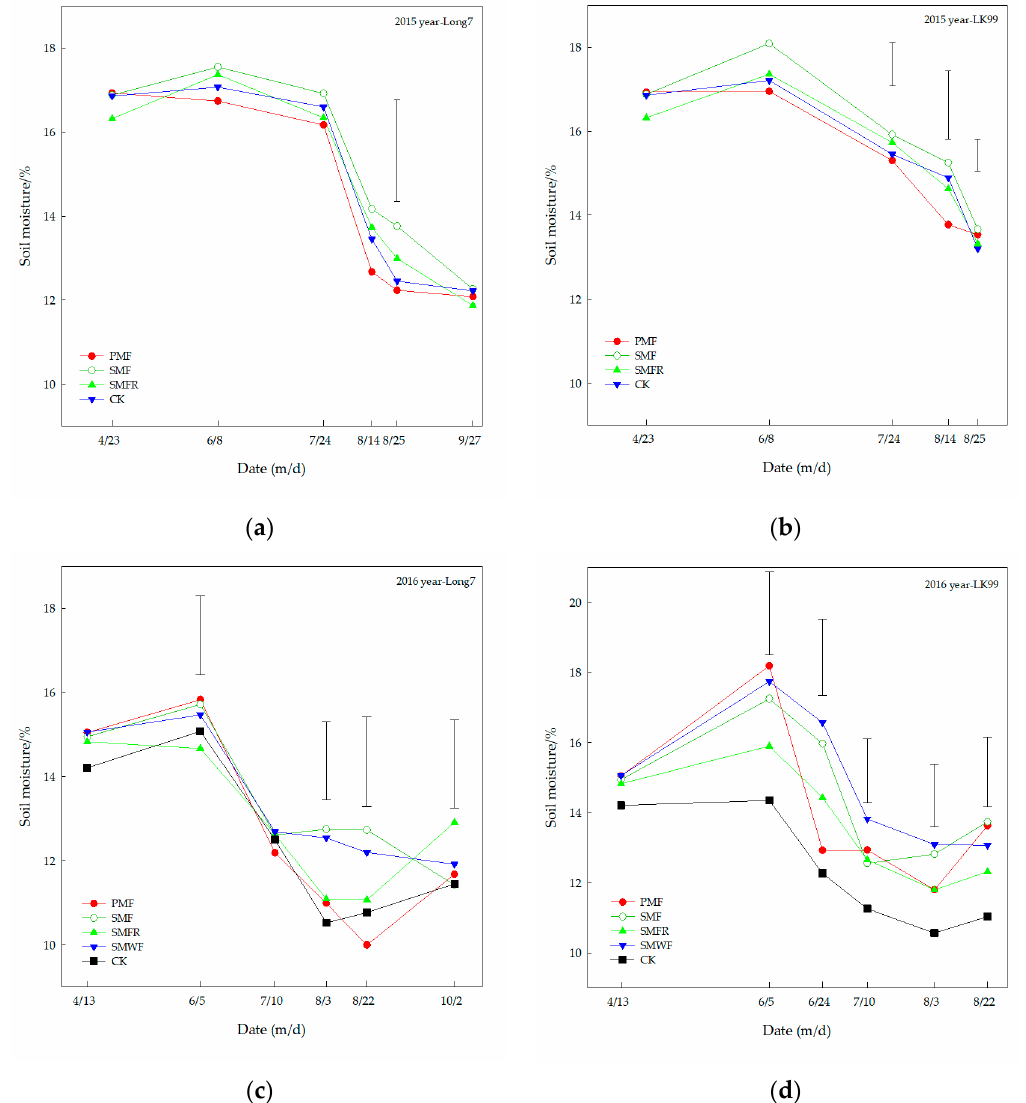
Figure 6. ( a – d ) Change with the growth of 0–200 cm soil moisture content. ( a ) Different growth periods of late-maturing varieties (Long7) in 2015. ( b ) Different growth periods of early-maturing varieties (LK99) in 2015. ( c ) Different growth periods of late-maturing varieties (Long7) in 2016. ( d ) Different growth periods of early-maturing varieties (LK99) in 2016. The error bar indicated that there were significant differences in soil moisture among treatments at different growth stages (p < 0.05). The length of the error bar is the LSD value.